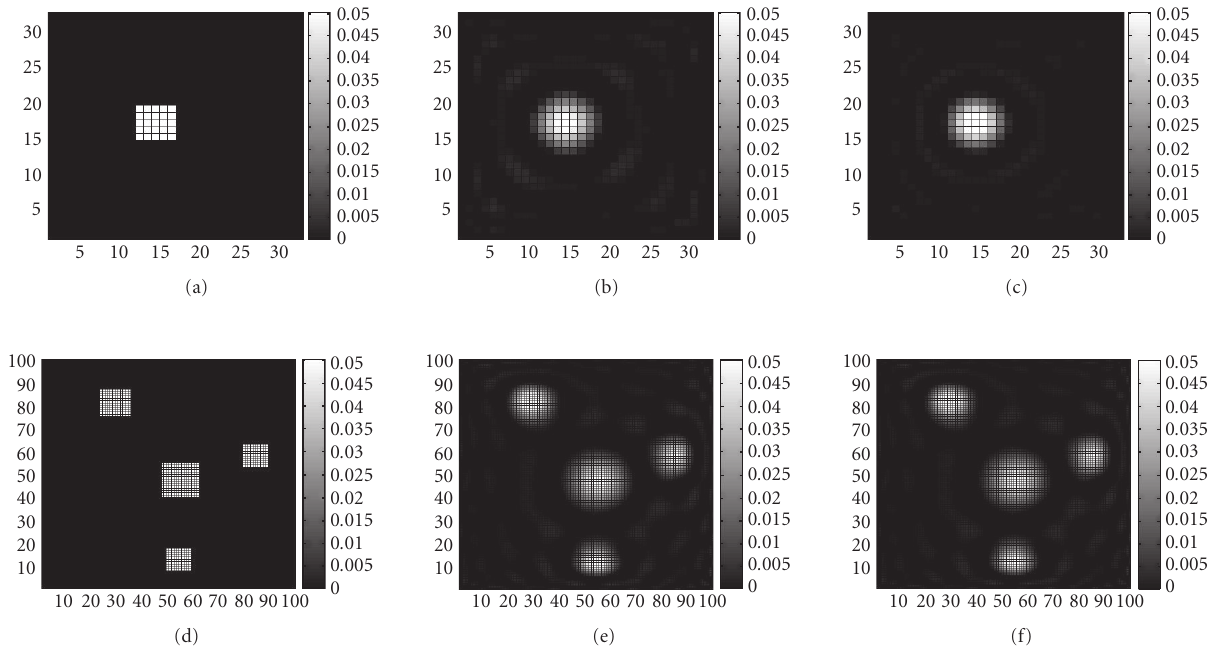
Figure 3: The original images and the reconstructions for single and multiprobe configurations with di ff erent datasets. (a) is the original distribution of the fluorescent yield η with 32 ∗ 32 voxels. (b) and (c) separately show the reconstruction of (a) with 256 measurements and 1024 measurements. (d) is the original η with image size of 100 ∗ 100 voxels. (e) and (f) show the reconstructions with 1024 measurements and 2048 measurements, respectively. For all of (b), (c), (e), (f), the iteration time in the preiteration step is 60.